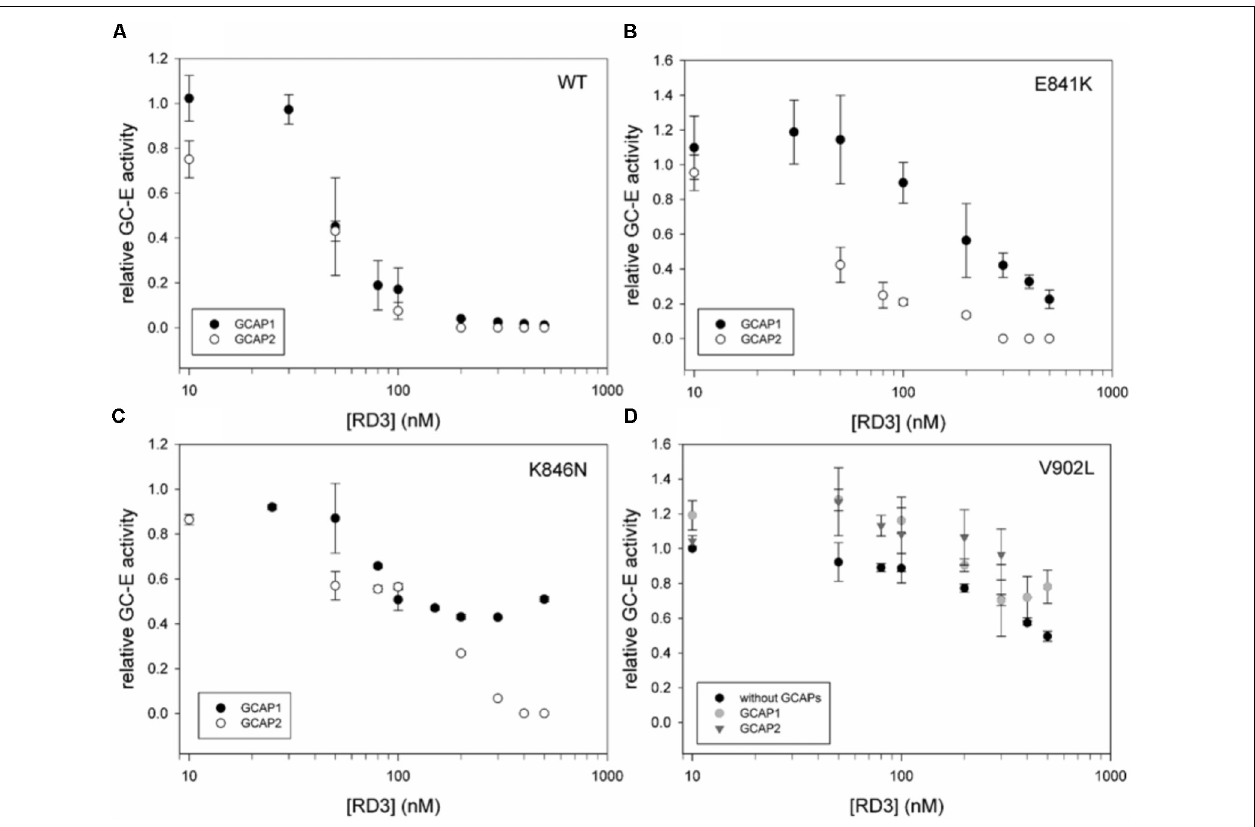
FIGURE 3 | Inhibition of GCAP activated GC-E wildtype and mutants by RD3. (A) GC-E wildtype. (B) GC-E mutant E841K. (C) GC-E mutant K846N. (D) GC-E mutant V902L. GC-E from HEK cells was incubated with either GCAP1 or GCAP2 (5 µ M) or no GCAPs (V902L) and increasing concentrations of RD3 (0–500 nM) at low [Ca 2 + ] (1.7 nM). The GC-E activity at a concentration of 0 nM RD3 was set to 1 and the relative activity was calculated due to the amount of produced cGMP. Each data point represents the mean value of three replicates with the standard deviation. The experiment was repeated with similar results.